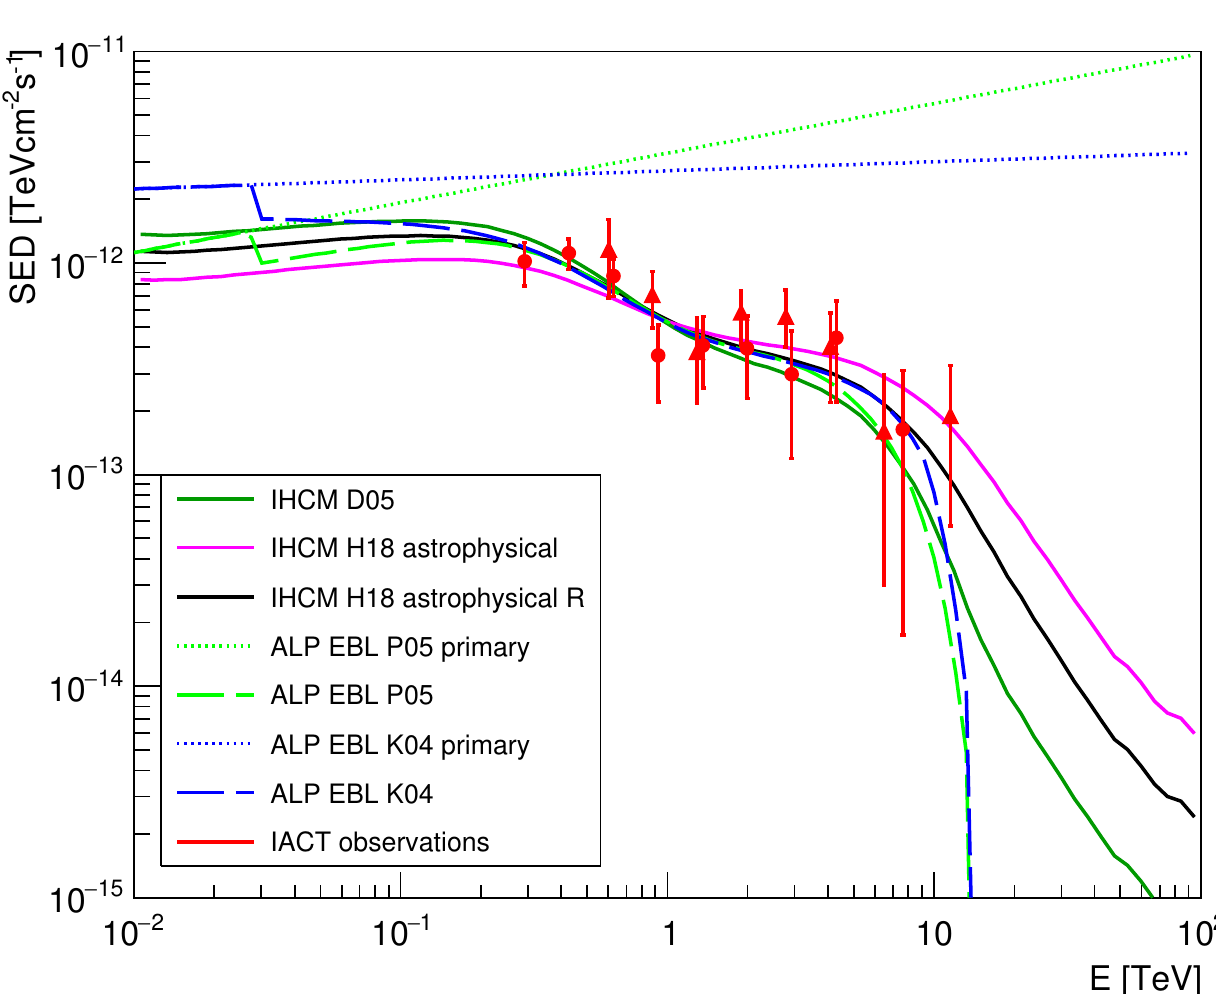
Figure 2. Comparison of IHCM model SEDs of the blazar 1ES 0229+200 ( z = 0.14) with ALP SEDs from [14] ( z = 0.116) and IACT measurements. Solid lines denote IHCM model SEDs: black line corresponds to astrophysical R (H18) model of EGMF, magenta line—to astrophysical (H18), and olive line—to D05. Green dashed curve corresponds to ALP model SEDs assuming P05 EBL model [54], blue dashed curve—to ALP model SEDs assuming K04 EBL model [55]. Dotted lines represent primary spectra in ALP models. Finally, symbols with error bars denote IACT measurements of the observable SEDs of 1ES 0229+200: red dots correspond to VERITAS measurements, red triangles—H.E.S.S.